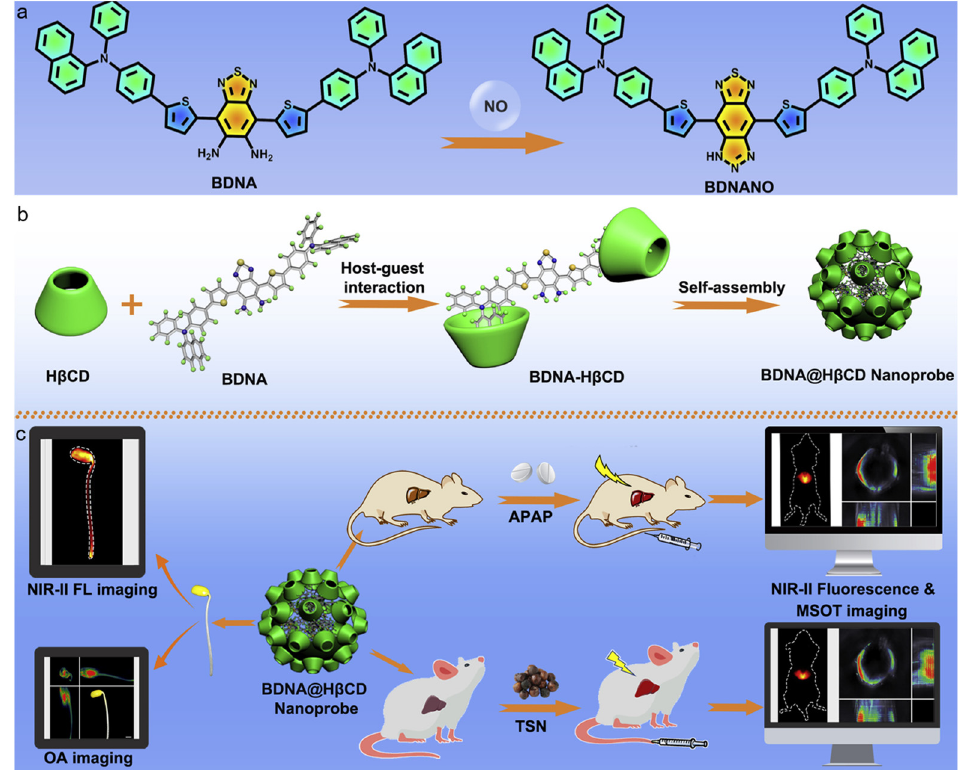
Figure 15. ( a ) The mechanism of BDNA for NO detection; ( b ) the formation of host–guest supramo- lecular complex BNDA–H β CD and the nanoprobe; ( c ) the BNDA@H β CD nanoprobe for in vivo NIR-II fluorescence and PA imaging of liver injury and detecting NO in soybean sprouts. (Reproduced with the permission from Ref. [165]. Copyright 2021, The